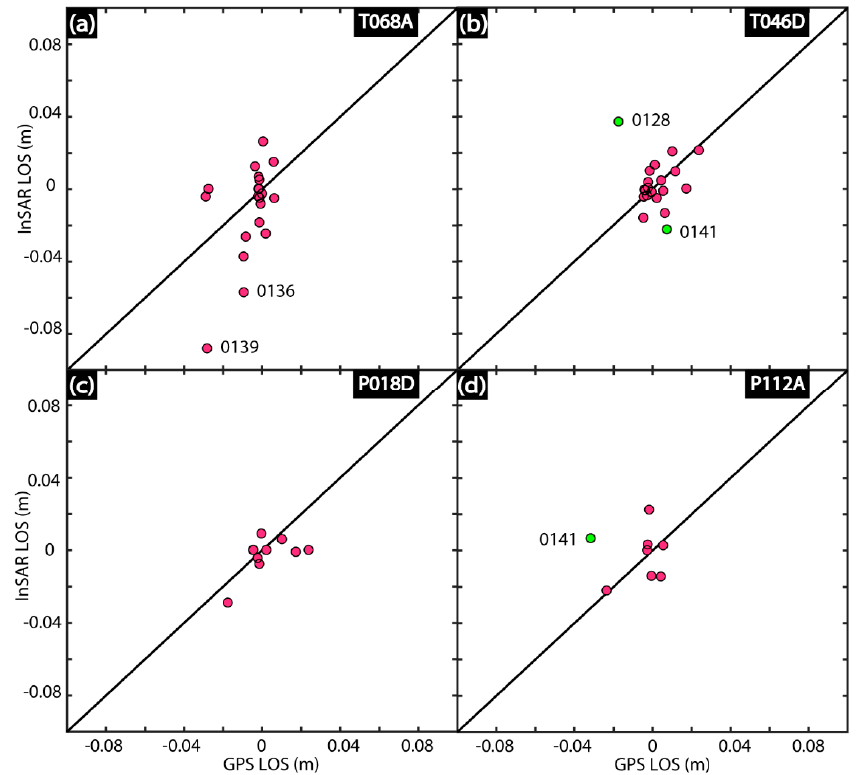
Figure 4. Comparison between the GPS-projected and InSAR-observed line-of-sight (LOS) displacements on T068A ( a ), T046D ( b ), P018D ( c ), and P112A ( d ). The green dots represent the sites between the GPS-projected and InSAR-observed LOS displacements are greater than 3